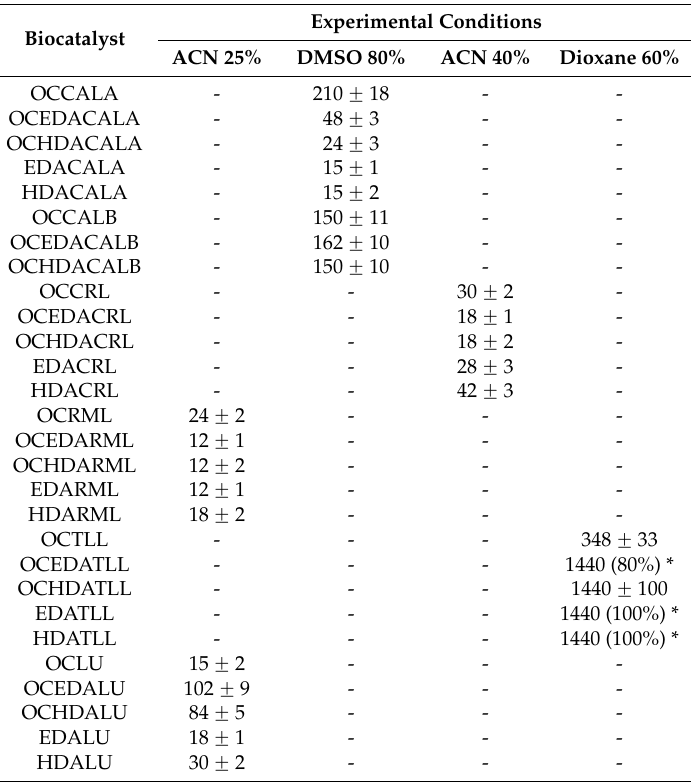
Table 2. Half-lives (in minutes) of the different biocatalysts in the presence of different concentrations of organic solvents in buffer TrisHCl at pH 7 and incubated at 30 ˝